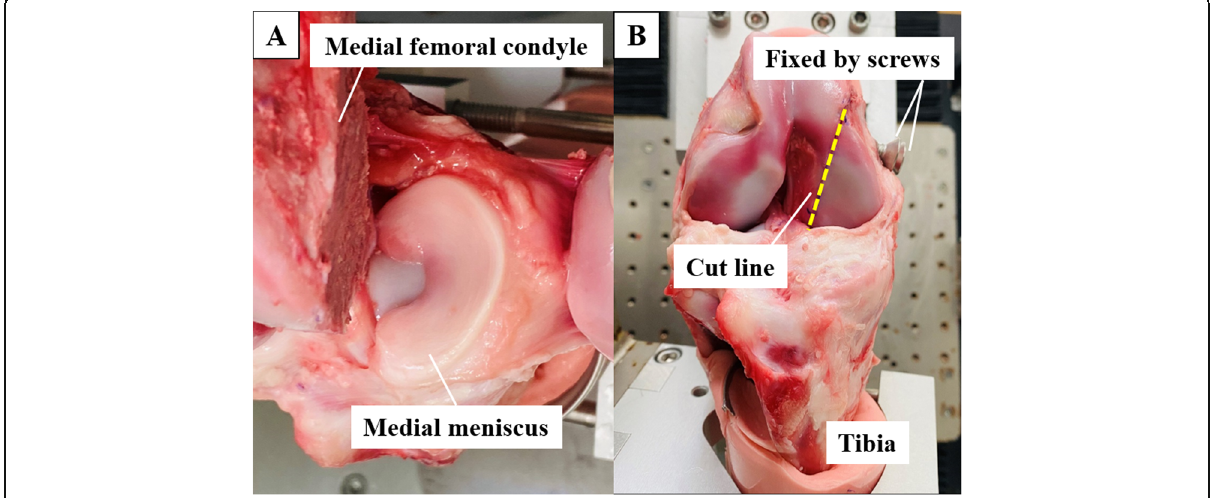
Fig. 2 The porcine knee after osteotomy of the medial femoral condyle. a Over the top view of medial meniscus. b Frontal view of knee